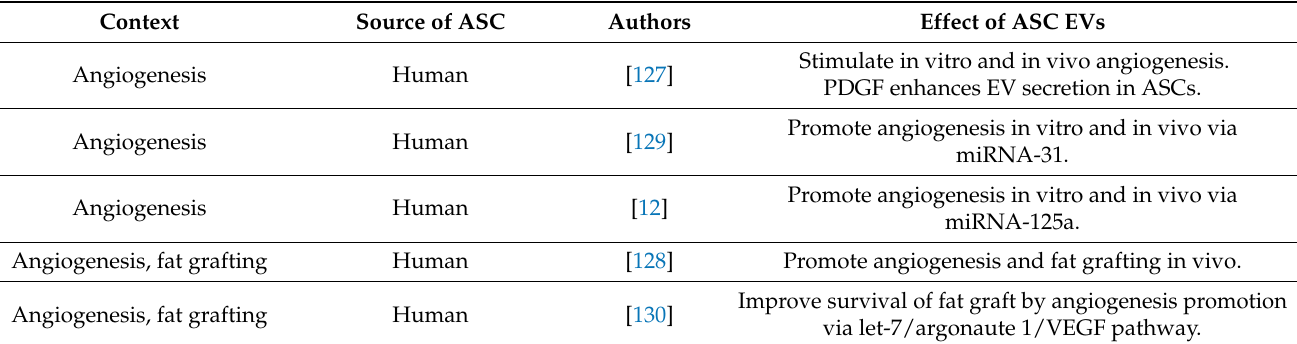
Table 3. Summary of angiogenesis-related studies involving adipose-derived mesenchymal stem/stromal cell-derived extracellular